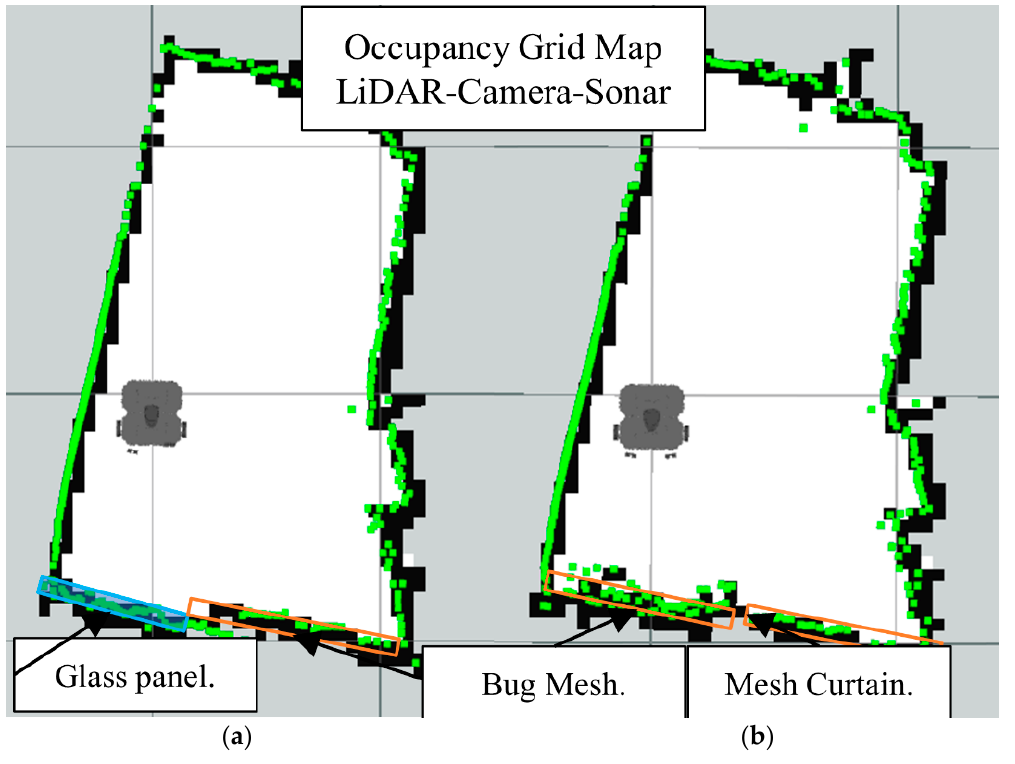
Figure 31. Occupancy grid maps showing the: ( a ) Ground truth (reference map); ( b ) LiDAR-Ca- mara-Sonar fusion generated map with glass as main obstacle.